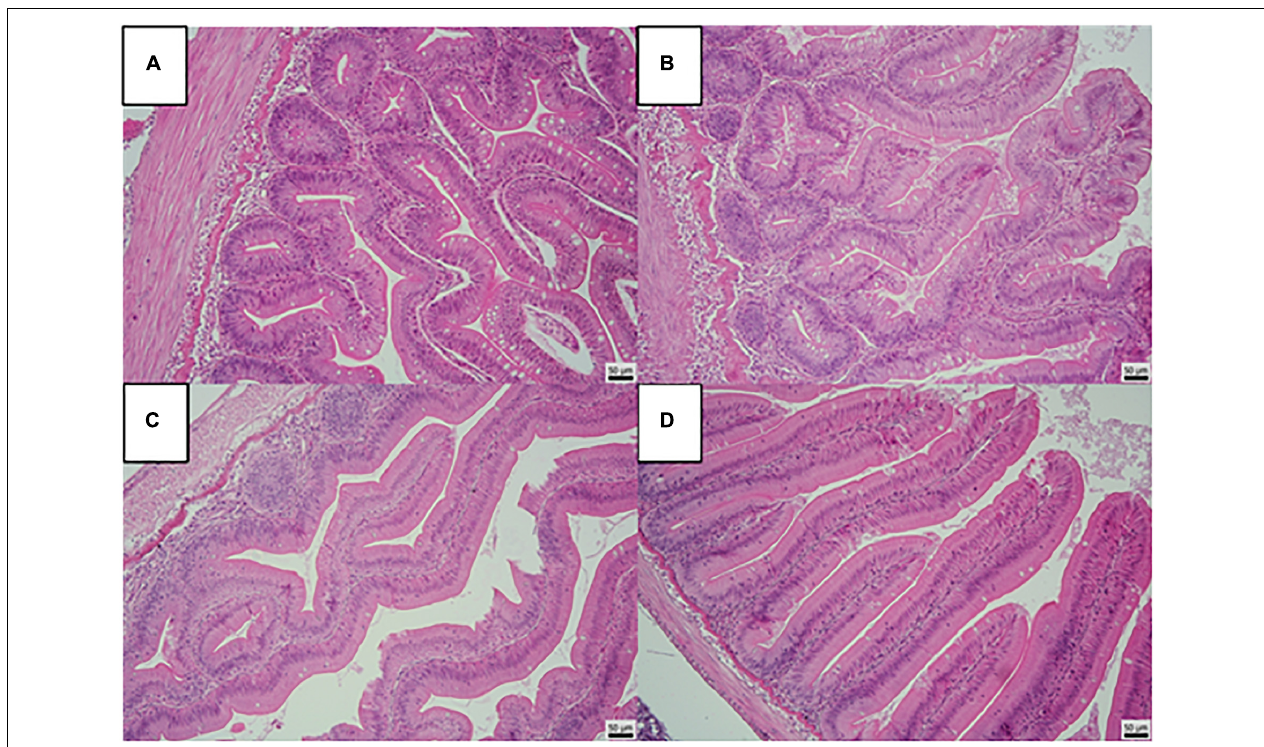
FIGURE 4 | Foregut structure of rainbow trout fed fresh fish oil diet (FFO diet, (A) ), oxidized fish oil containing diet (OFO diet, (B) ), OFO diet supplemented with 500 mg kg − 1 VC and 400 mg kg − 1 VE (OFO+C500+E400, (C) ) or 1,000 mg kg − 1 VC and 800 mg kg − 1 VE (OFO+C1000+E800, (D) ). (H&E, scale bar 50 µ